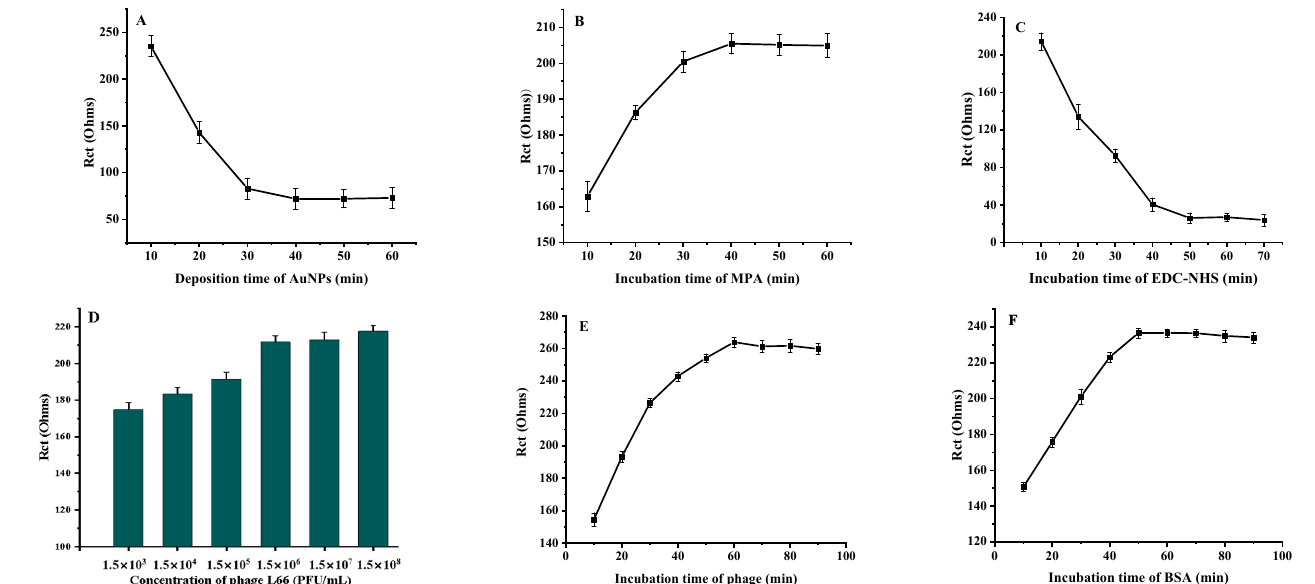
Figure 4. Optimized parameters for biosensor construction process. ( A ) Deposition time of AuNPs. ( B ) The incubation time of MPA. ( C ) The incubation time of EDC/NHS. ( D ) Concentration of phage L66. ( E ) The incubation time of phage L66. ( F ) The incubation time of BSA.